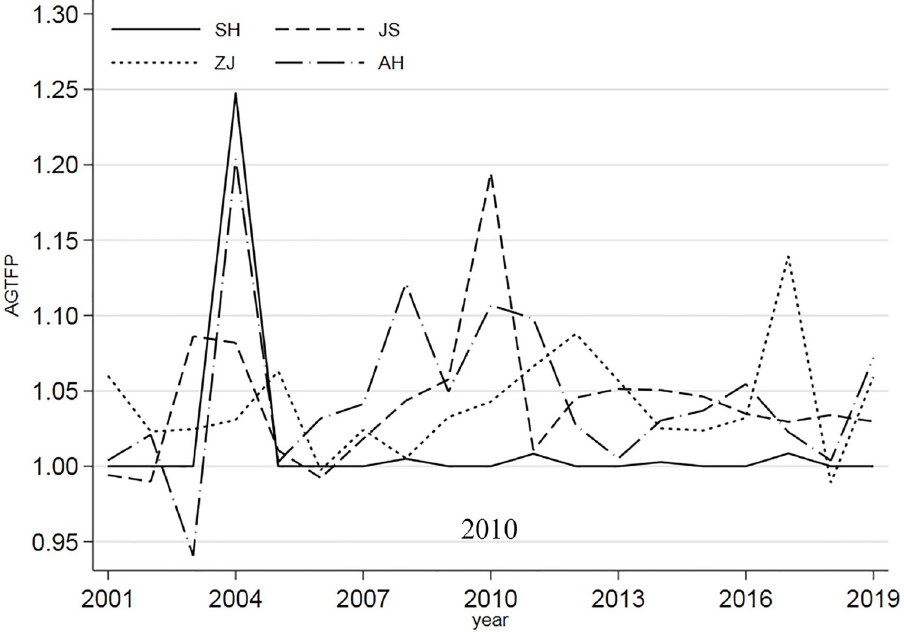
Fig 1. AGTFP index in the YRD region from 2001 to